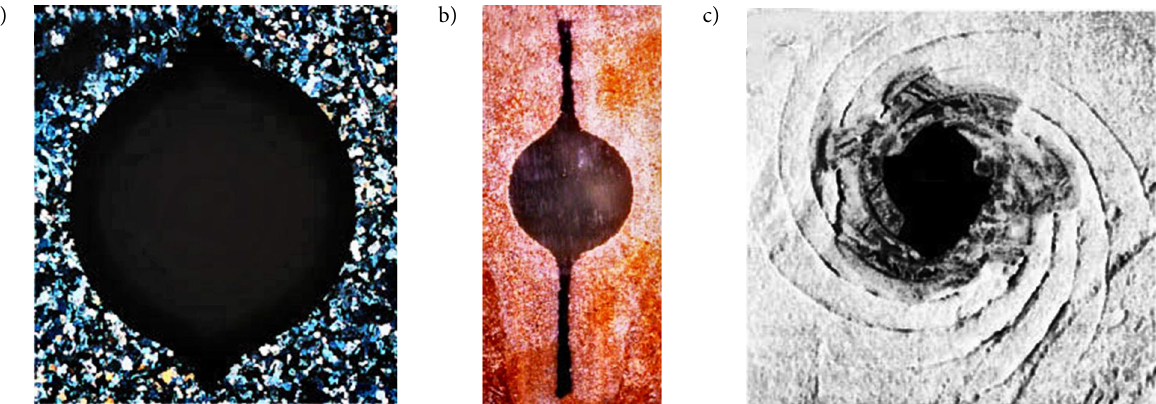
Figure 1. Breakouts: a) V-shaped (Haimson, 2007); b) slot shaped (Haimson & Lee, 2004); c) spiral shaped (Cerasi et al.,